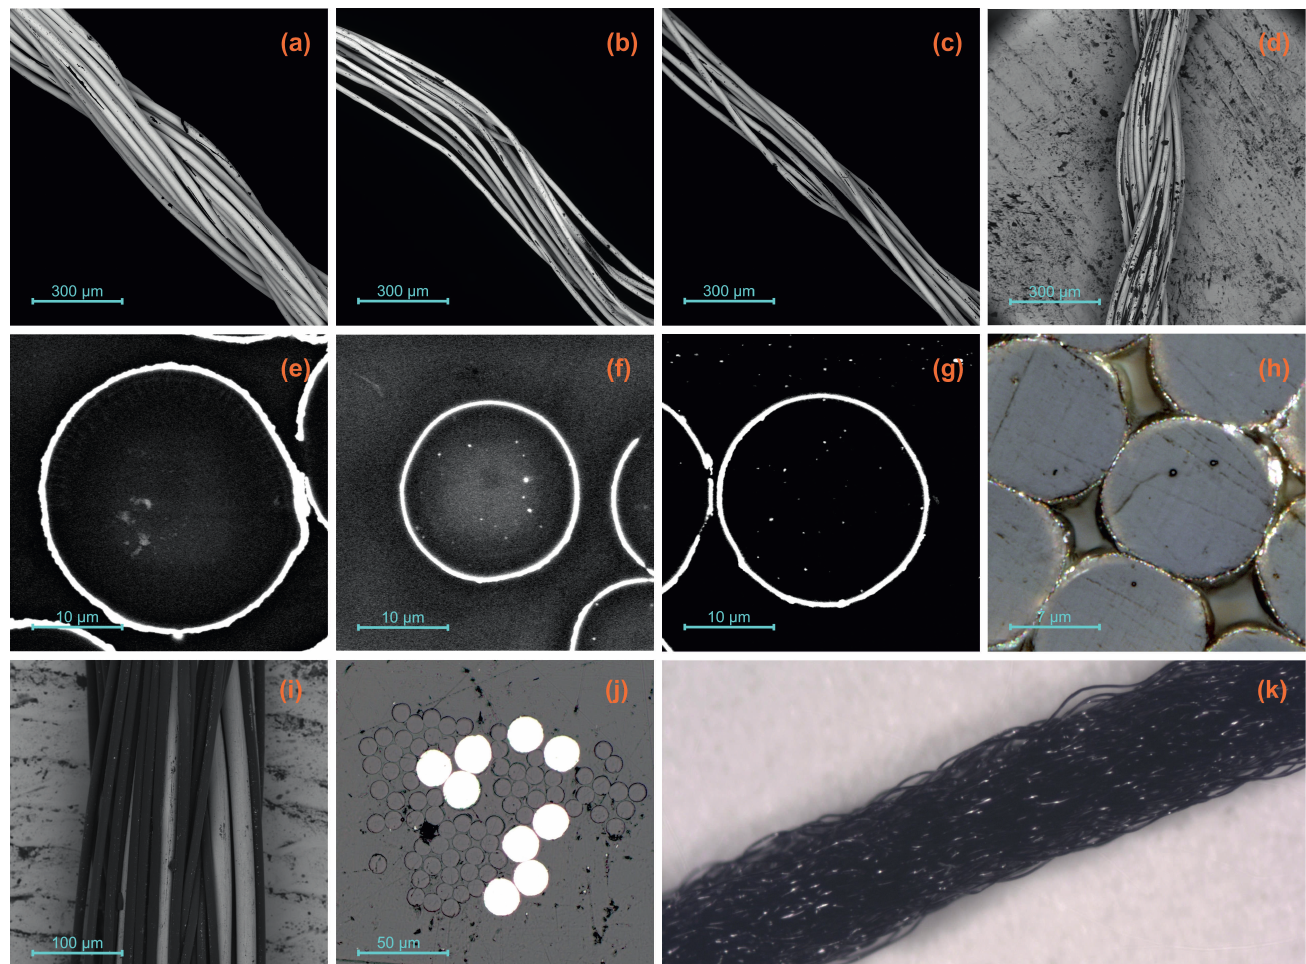
Figure 1. Scanning electron microscopy (SEM) and cross-section images of the conductive and non-conductive yarns prior to the knitting process. Yarns: ( a ) ELITEX, ( b ) SHLD33, ( c ) SHLD44, ( d ) MDR40, ( i ) STEEL, ( k ) PA base yarn; Cross sections: ( e ) ELITEX, ( f ) SHLD33, ( g ) SHLD44, ( h ) MDR40, ( j )